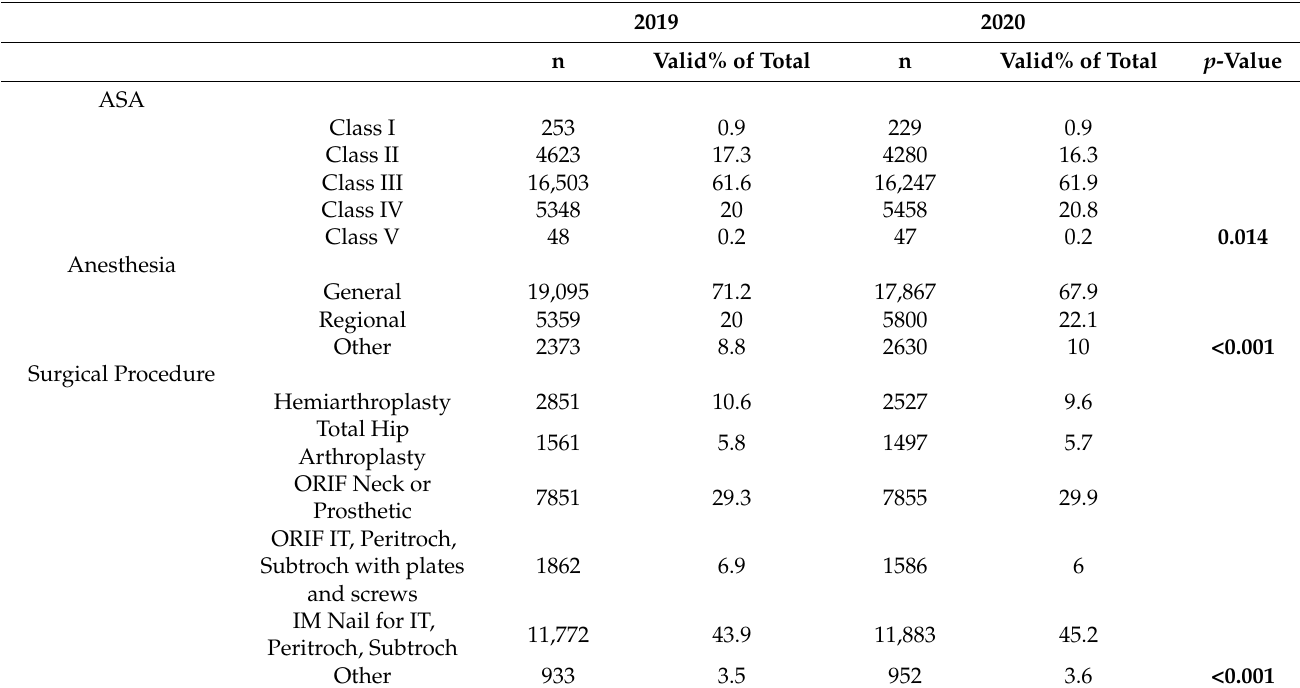
Cross Table Year of Diagnosis and Preoperative and Intraoperative Patient Characteristics with